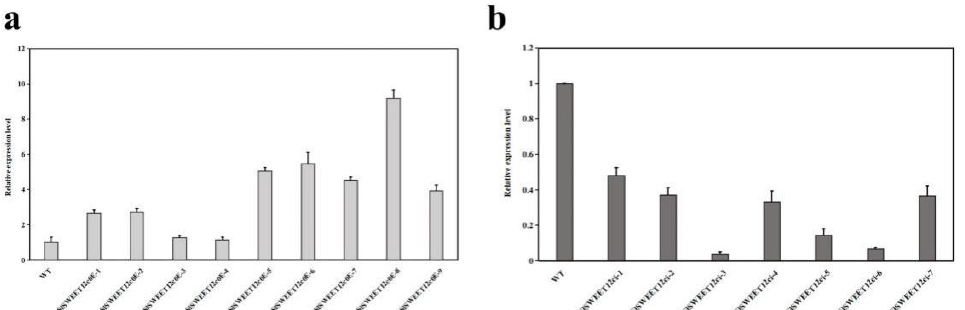
Figure 5. Relative expression level of SlSWEET12c in transgenic plants. ( a ) Relative expression level of OE-12c lines. ( b ) Relative expression level of RNAi-12c lines. The wild type (WT) expression data were normalized to 1, and the beta-actin gene was used as an internal control. The primers are shown in Supplementary Table S1. Results are representative of at least three experiments.